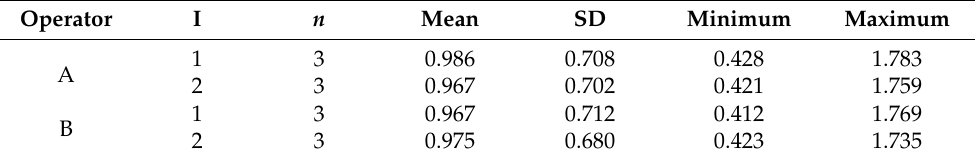
Table 2. Descriptive statistics of the volume of the cement remaining after lingual multibracket